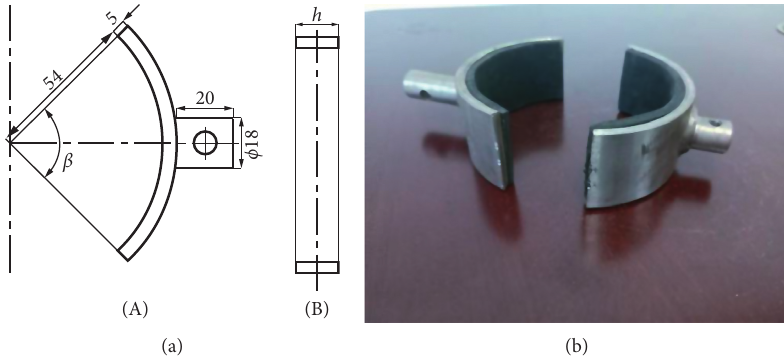
Figure 2: Clamping parts. (a) Structure of clamping elements. (A) Front view. (B) Side view. (b) A set of clamping